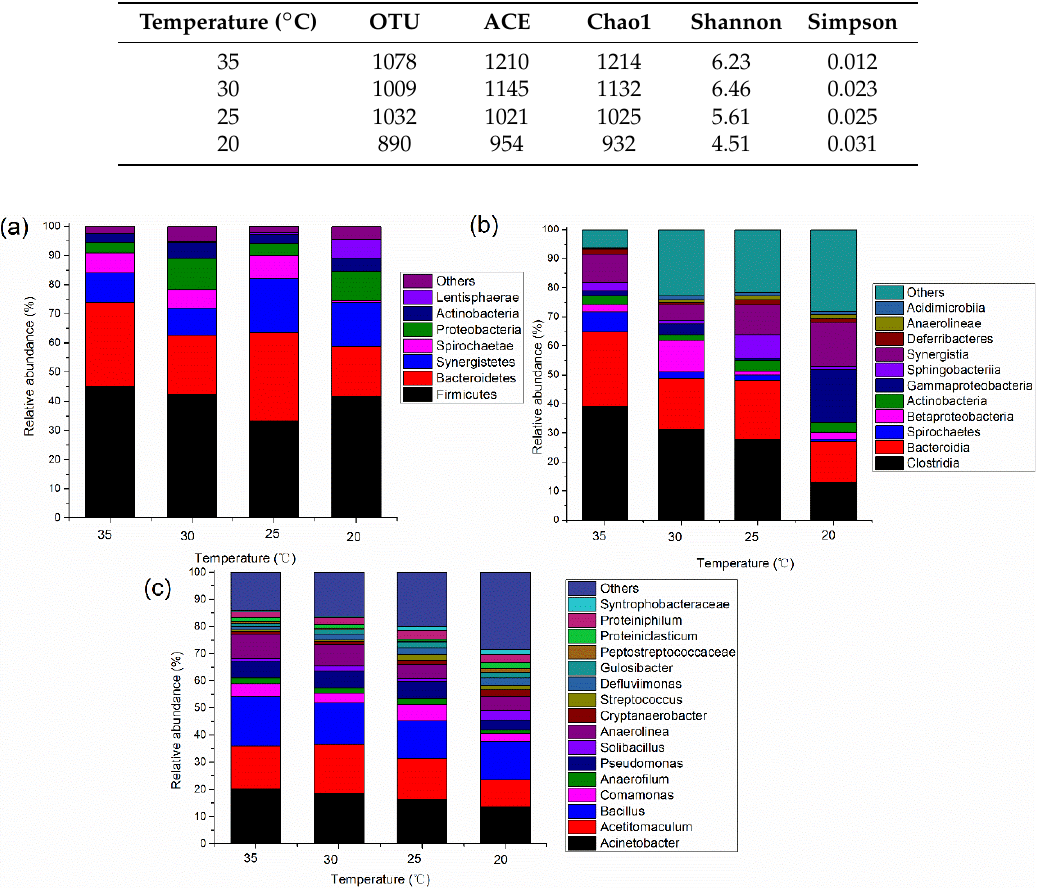
Figure 4. Microbial community structure in the acidogenic phase at different temperatures: ( a ) phylum level; ( b ) class level; ( c ) genus level.